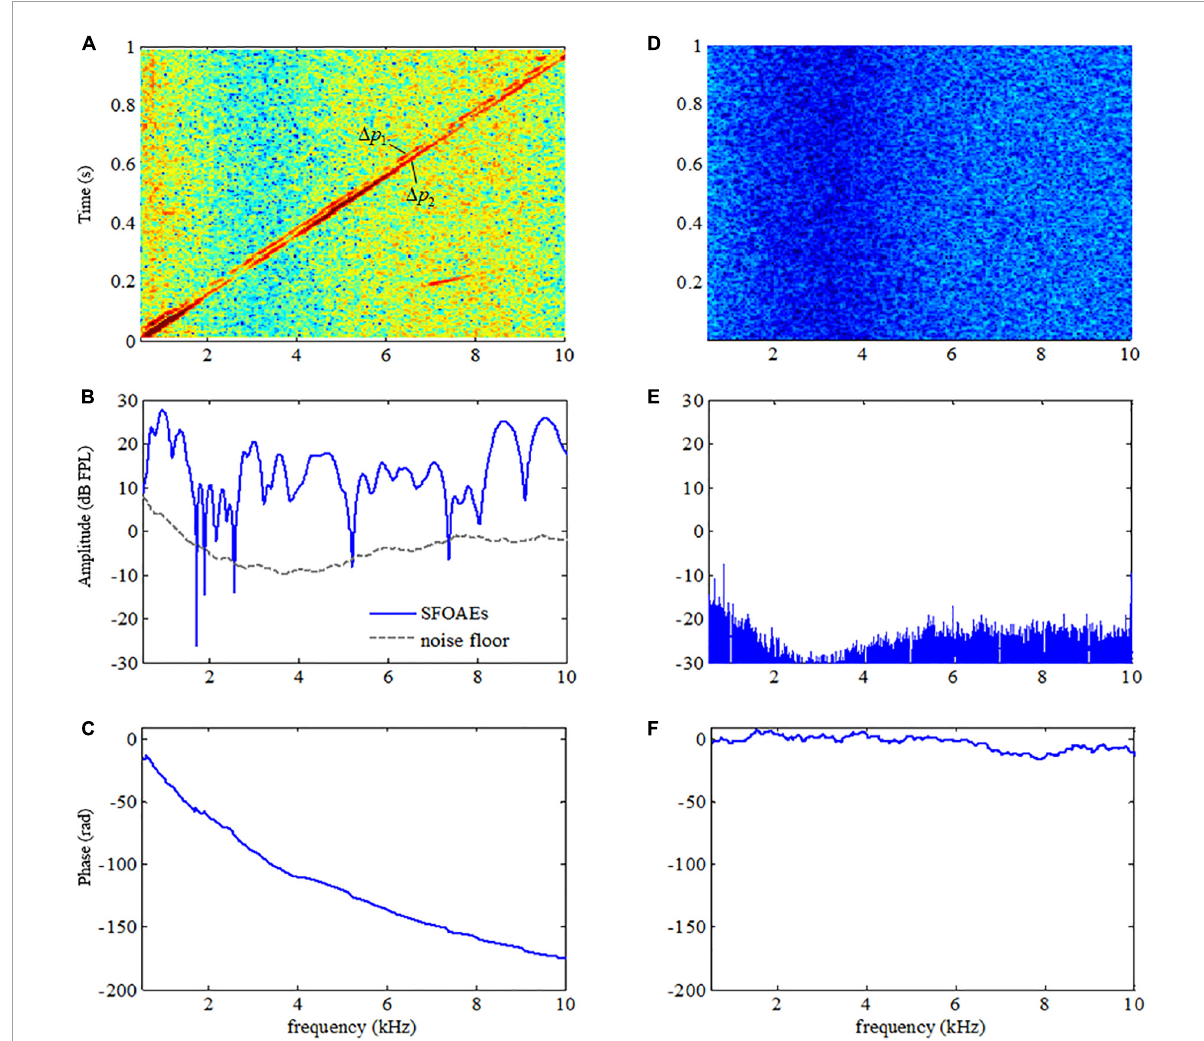
FIGURE3 Difference in the spectrograms, amplitude, and phase spectra between the acoustic responses in a human ear ( A–C , respectively) and in a plastic tube ( D–F ,